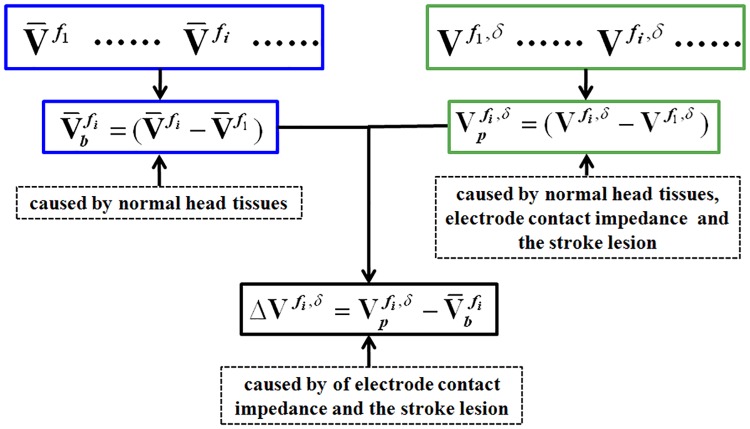
The procedure to obtain the boundary voltage difference for image reconstruction, where δ represents the different levels of effects of contact impedance and fi denotes the frequency.